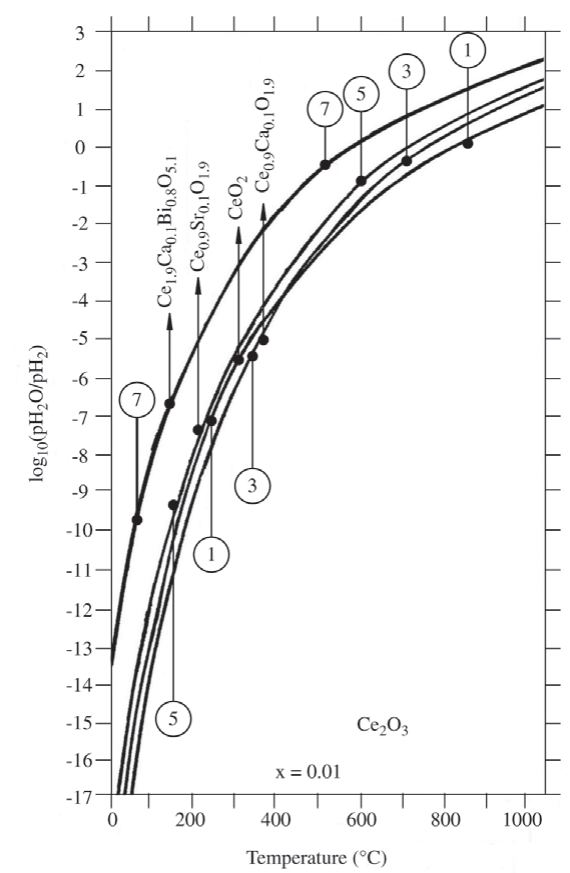
Figure 1. Diagram of log cerias doped with Ca, Sr and Bi; x = 0.1.